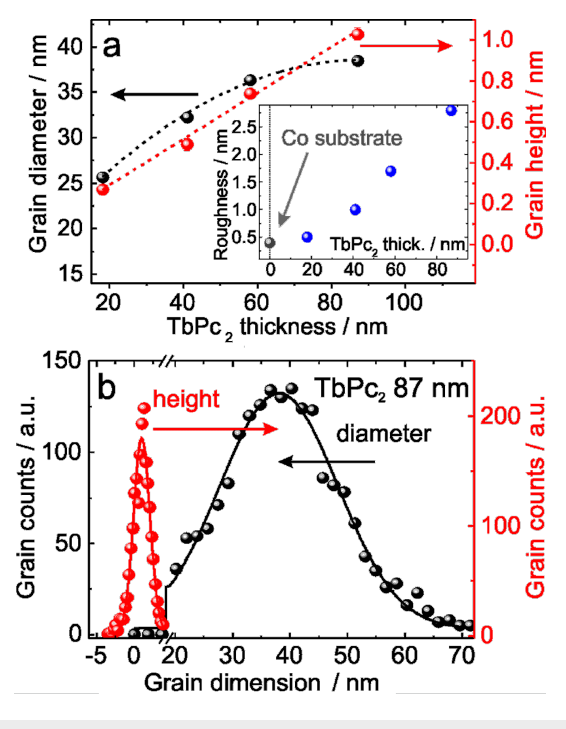
Figure 5: AFM statistical analysis of TbPc 2 thin films. (a) Average grain diameter and height as a function of the organic film thickness. Dotted lines are guide to the eye to show the tendency of the grain height and grain diameter with the thickness. The inset shows the dependence of the roughness of the organic films thickness. (b) Diam- eter and height histograms for an 87 nm TbPc 2 film. Error bars (with sizes comparable to plotted dot symbols) in (a) are obtained from Gaussian fits in histograms as shown in